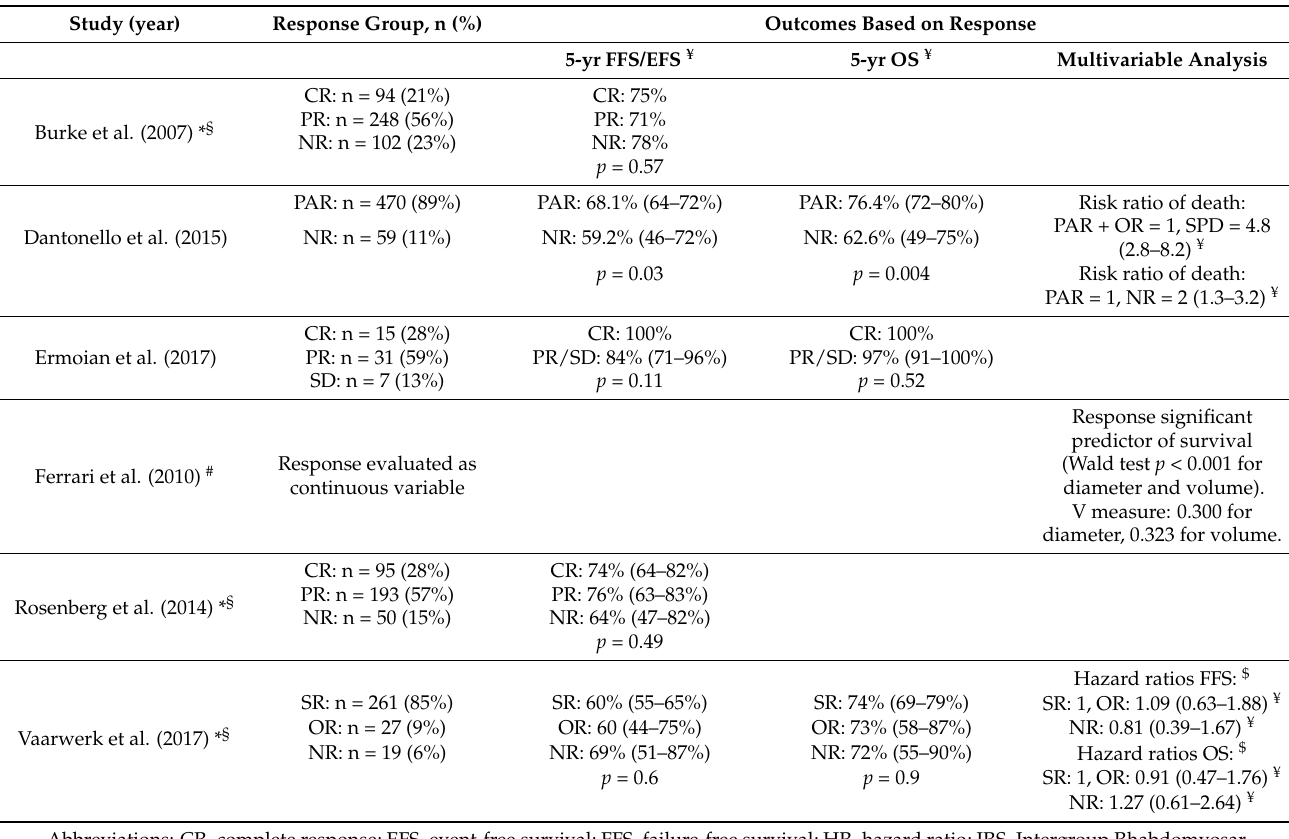
Table 4. Survival for response groups of included